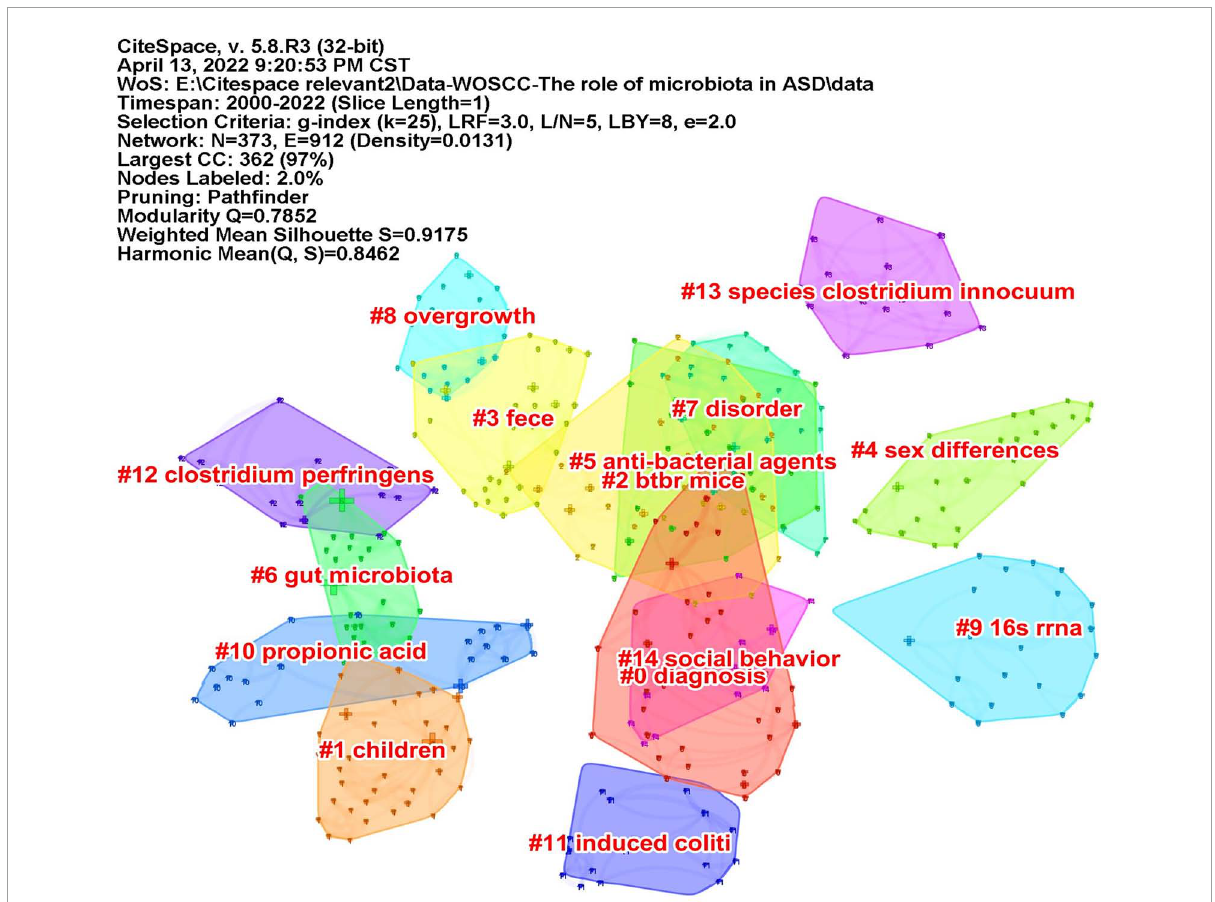
FIGURE8 The map of keyword clusters. The clusters are arranged in the descending order of their